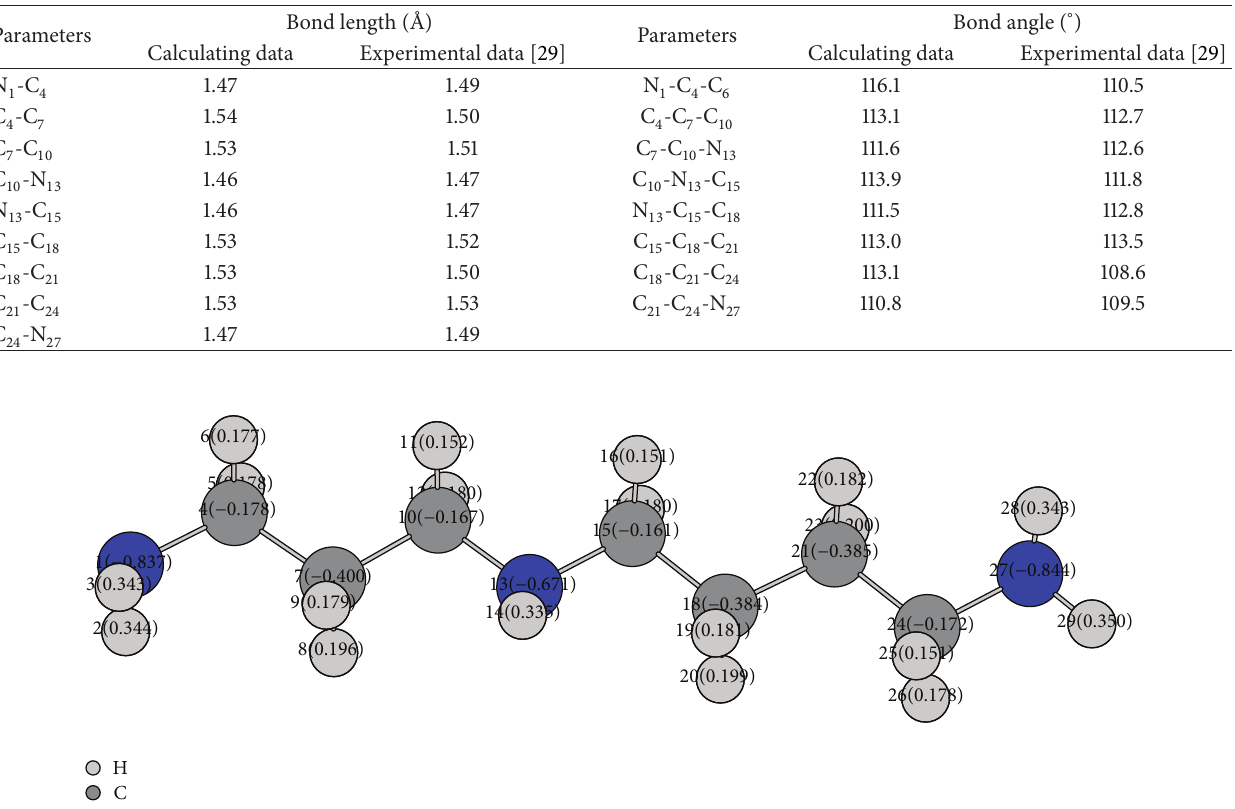
Table 2: Structural parameters of atrazine calculated using the B3LYP/6-31+(d, p) level and available experimental